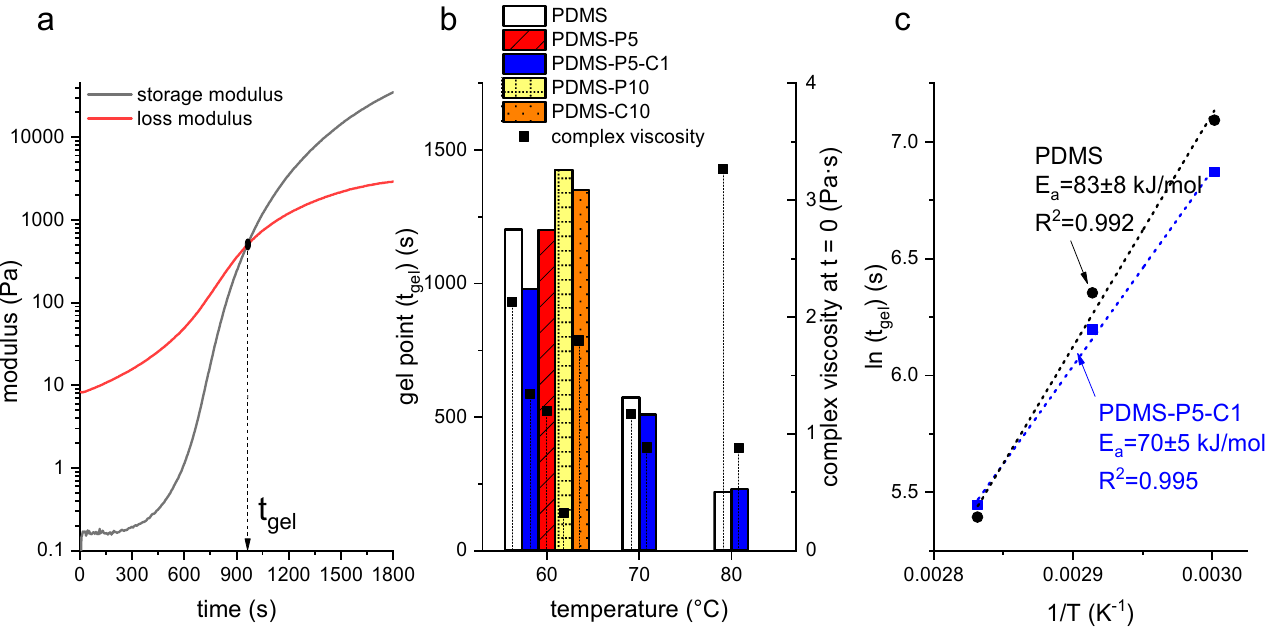
Figure 1. ( a ) Representative curve obtained in the rheological tests on uncured PDMS-P5-C1 at 60 ◦ C; ( b ) gel point as a function of temperature and complex viscosity at the beginning of the test (t = 0) for some selected compositions; ( c ) natural logarithm of t gel as a function of 1/T (experimental data and linear regression) for the samples PDMS and PDMS-P5-C1. The calculated activation energy (E a ) and the value of R 2 of the linear regression are also